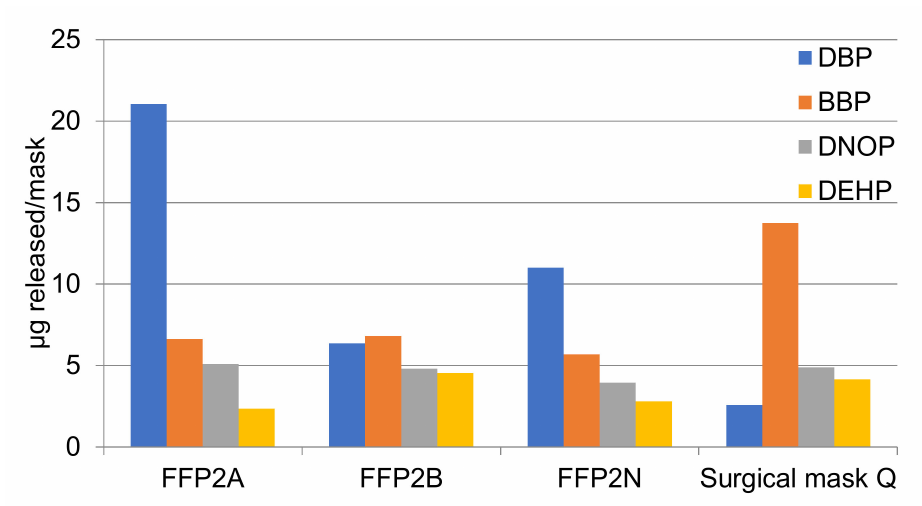
Figure 13. Phthalates migrating from each mask, in µ